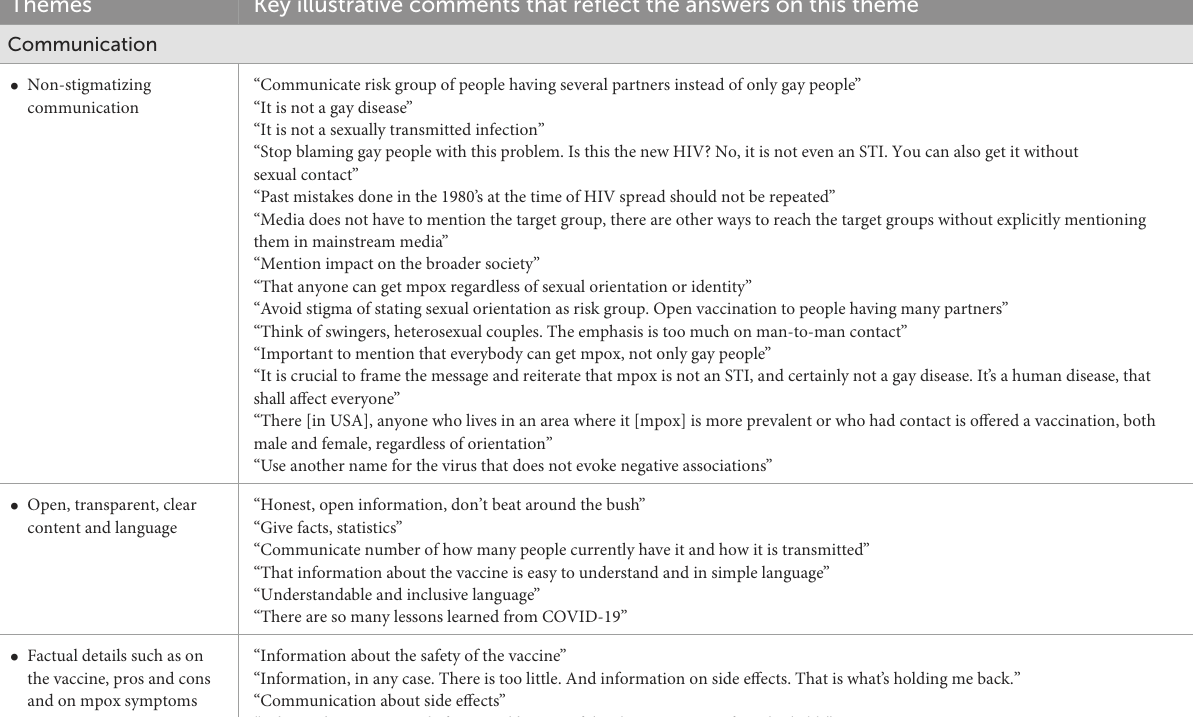
TABLE 3 Recommendations for health-professionals and institutions to communicate on mpox vaccination and the mpox vaccination program, according to GBMSM/TGP participating in Dutch online mpox-survey (22 July-5 Sept 2022).